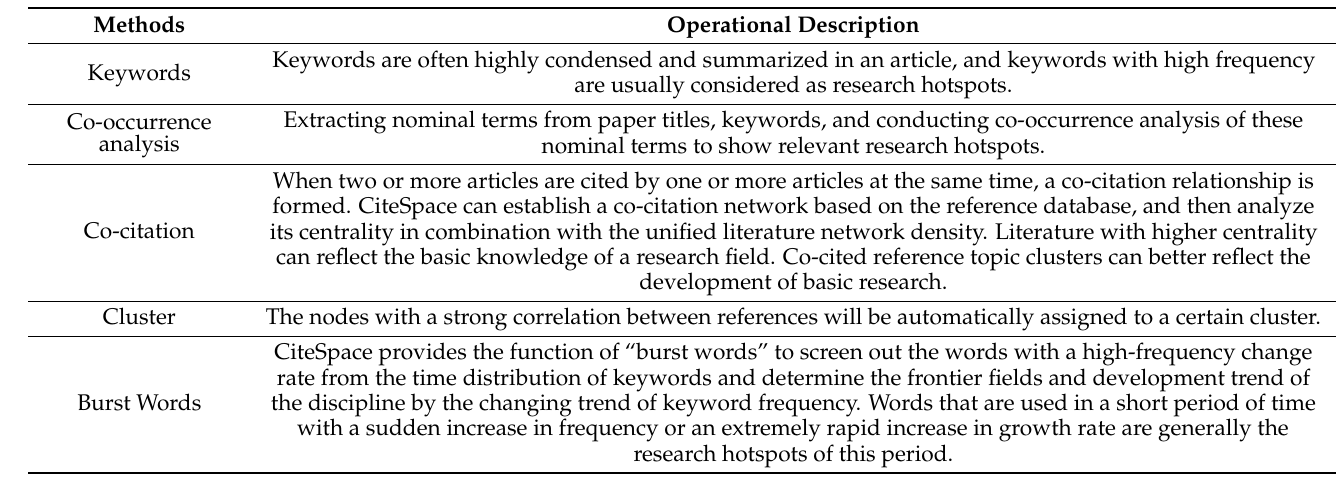
Table 1. A brief description of CiteSpace’s several operational principles